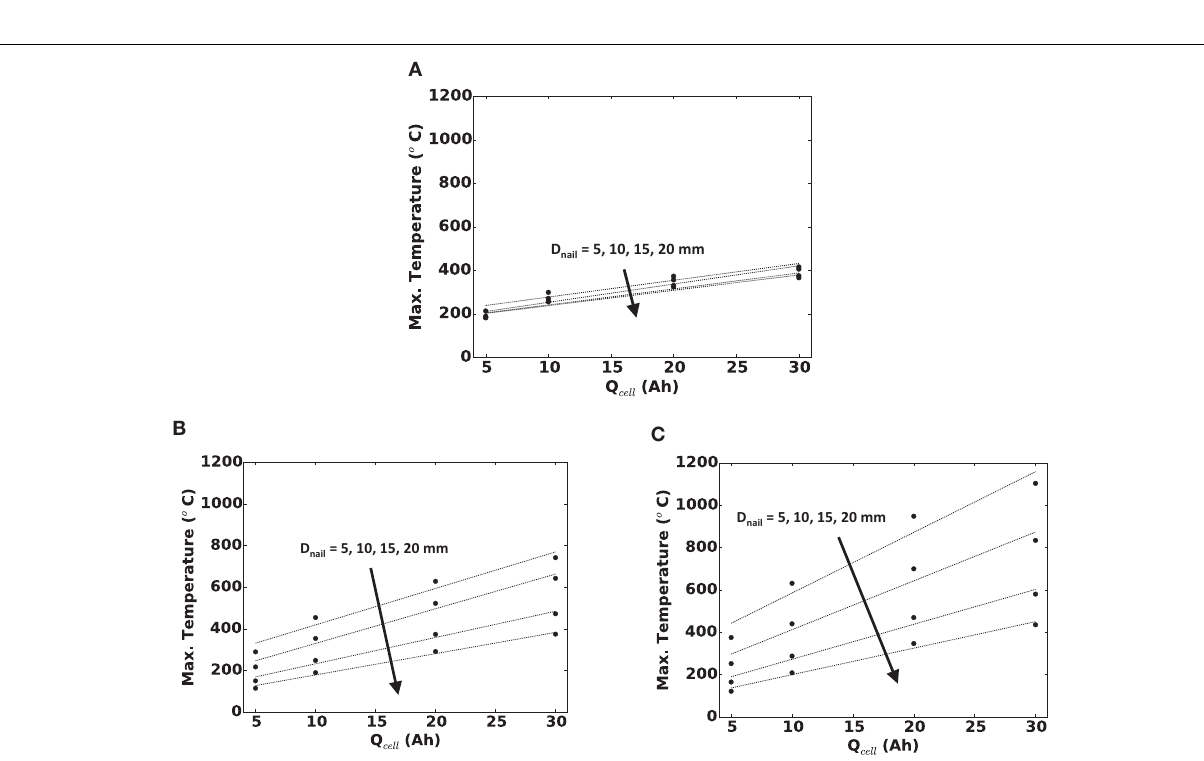
Frontiers in Energy Research |